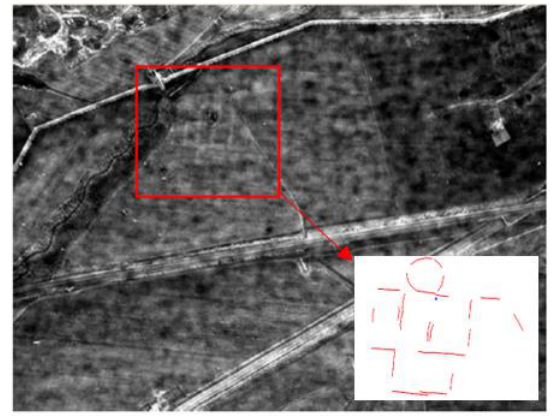
Figure 5. High Pass Filter on a historical photogram (SARA, 1932) and lineament extraction of the structure (on the right) On the same photogram of 1953 it was also possible to better appreciate structures nearby the Villa Ad Duas Lauros, through a 3X3 Edge Enhance Filter (figure 6). An exedra and a rectangular environment are in fact